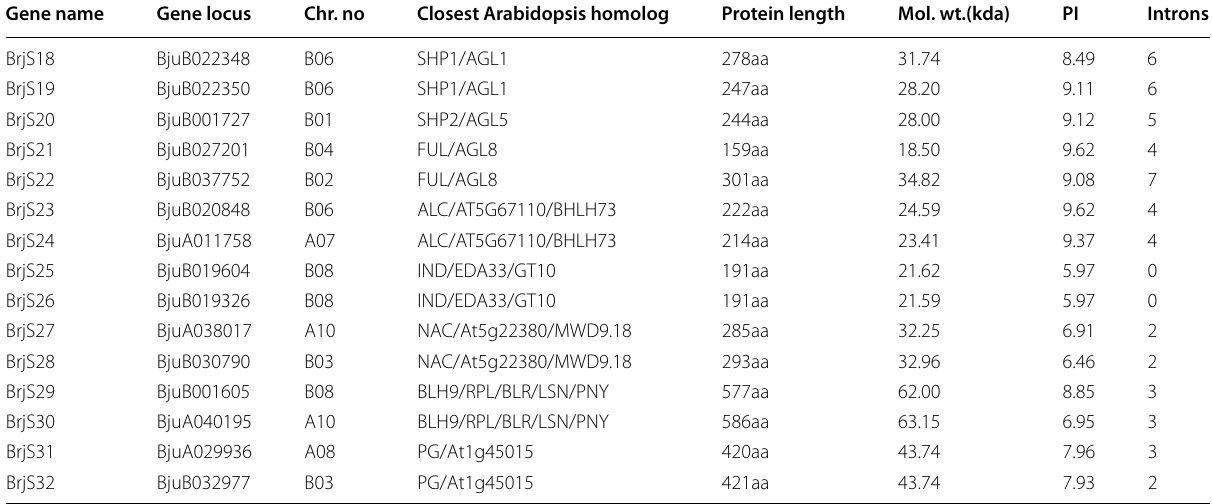
Table 3 In silico study of 15 shattering genes identified in B. juncea with their closest Arabidopsis homologs and sequence